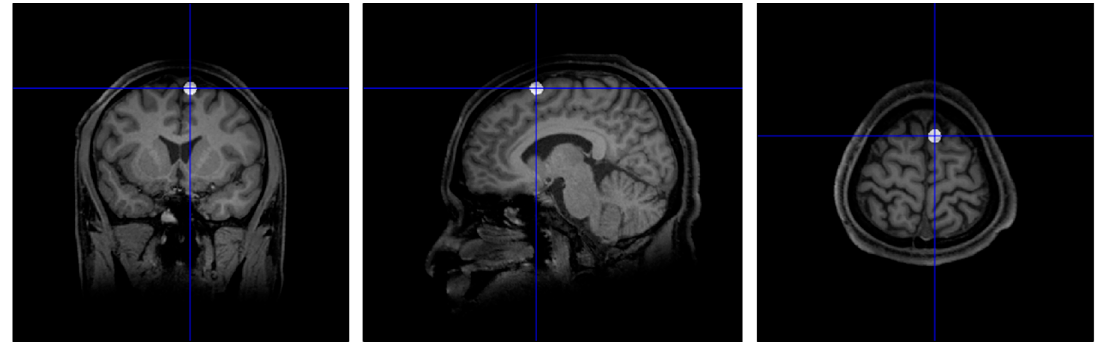
Figure 5. The position of right pre-supplementary motor area (pre-SMA) marked on the individual MRI scan.